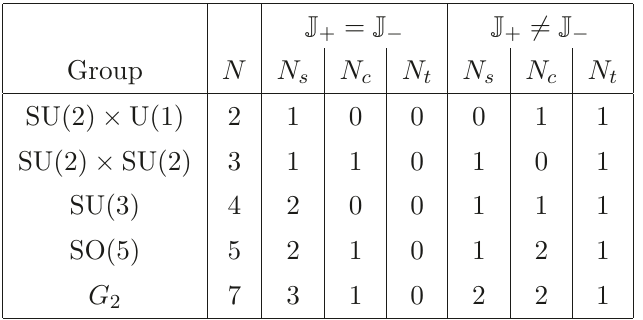
Table 1 . The coordinate content for the rank 2 non-abelian reductive Lie groups either taking the complex structures to be equal on the Lie algebra ( J + = J − ) or having the opposite sign on the CSA ( J + = J − ). The number of semi-chiral, chiral and twisted chiral coordinates are denoted N s , 6 N c and N t